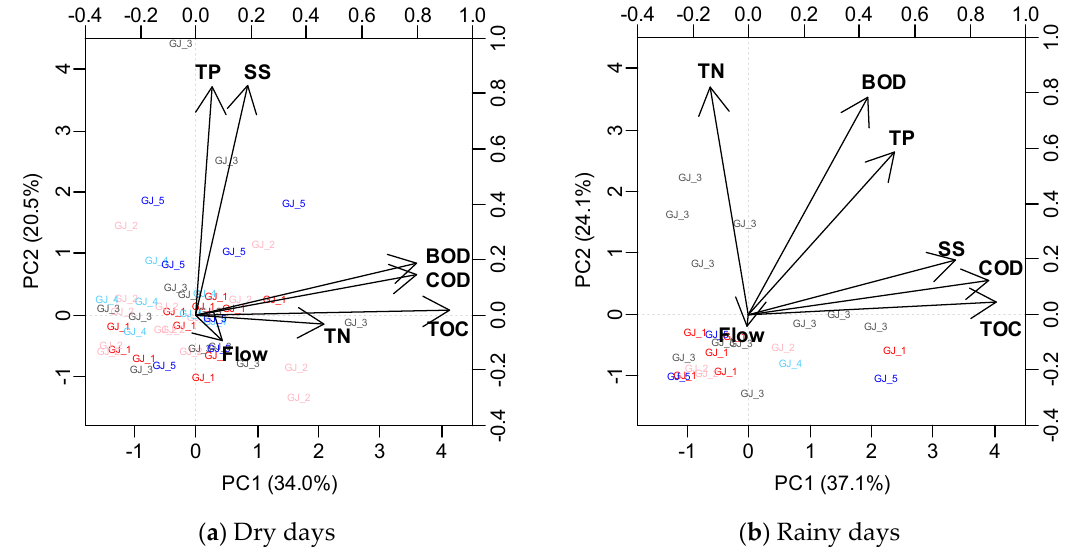
Figure 9. Biplot of principle components for water quality characteristics in Gongjicheon.